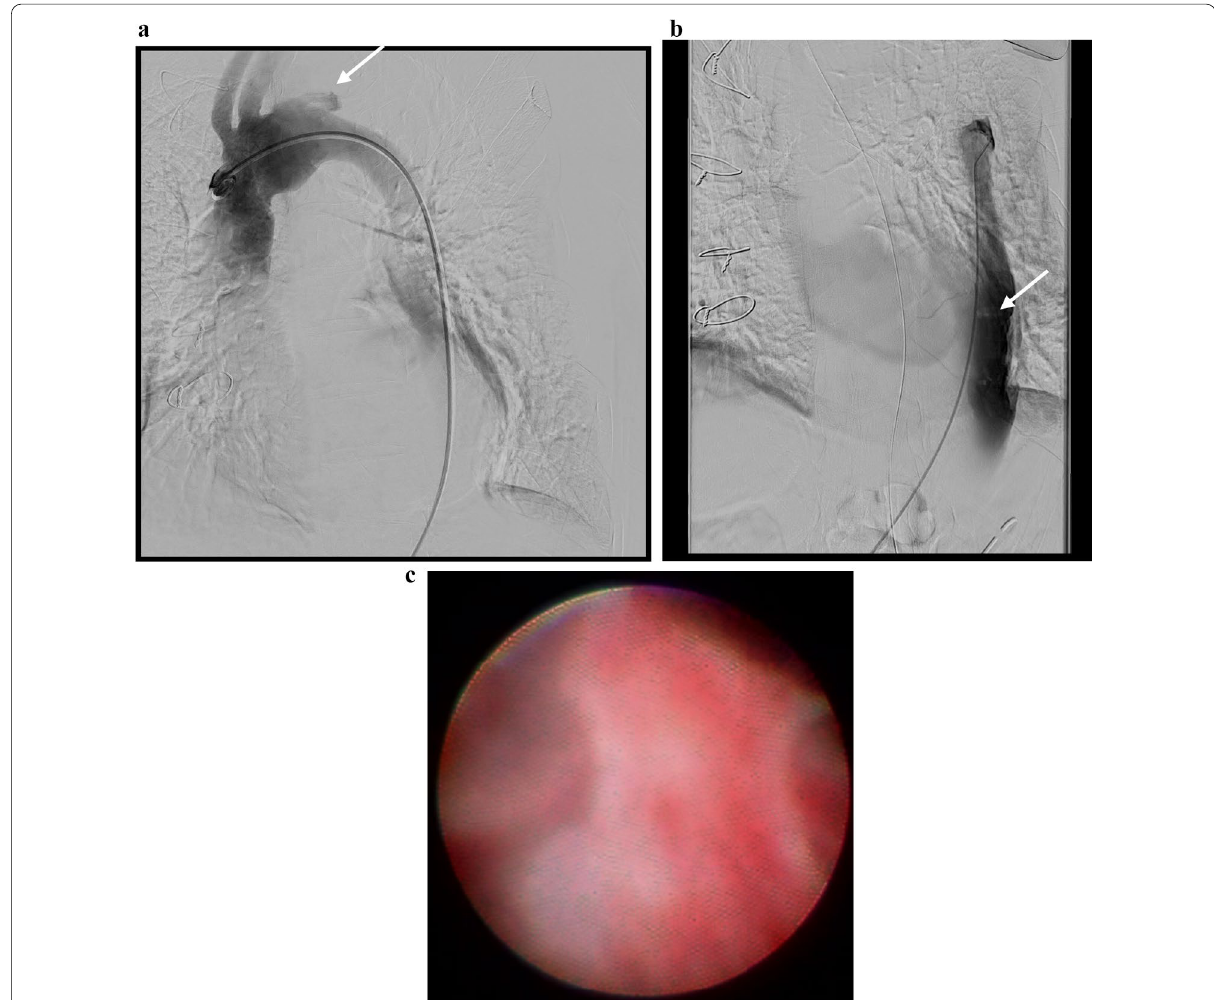
Fig. 2 Preoperative angiography and intraoperative angioscopy. a Aortography shows blood flow into the false lumen, and shows a new entry site from the true to the false lumen near the distal side of the anastomosis (arrow). b Contrast enhancement of the false lumen shows stagnation of blood in the distal part, and indicates a thrombus in the false lumen (arrow). c Angioscopy of the false lumen shows a free-floating